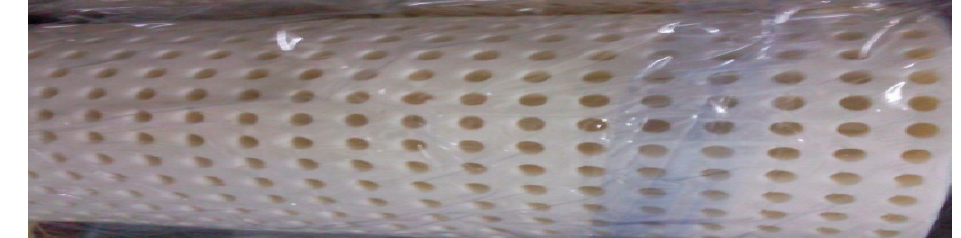
Figure 3. Latex component (Latex): length 1.9 m and 5.1 m; density 147.37 (kg/m 3 ); weight 7 kg, thickness 0.02 m. J. Mar. Sci. Eng. 2020 , 8 , x FOR PEER REVIEW